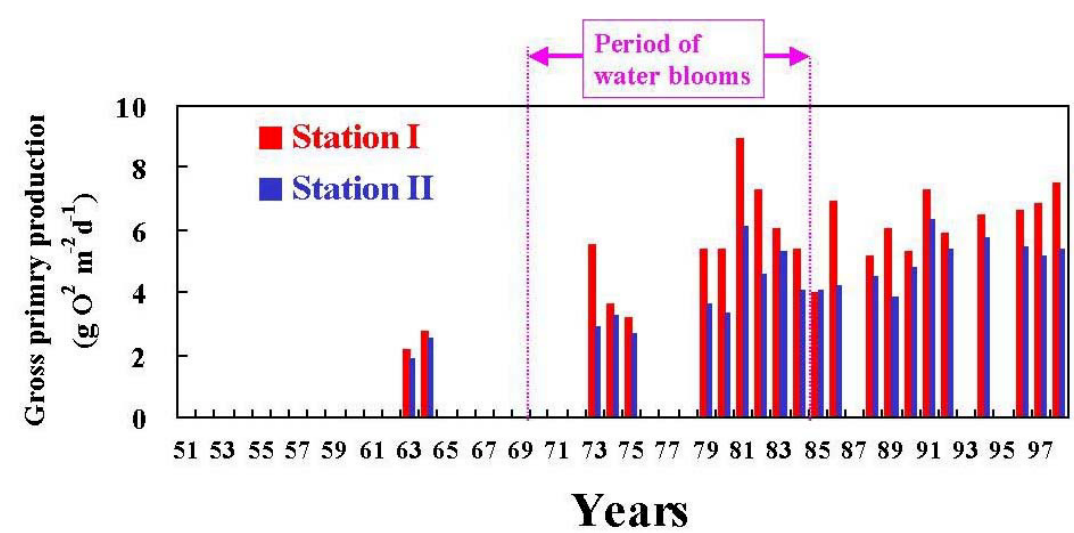
FIGURE 2. Annual mean gross primary production at Stations I and II of Lake Donghu (adapted from Xie et al.[4]).